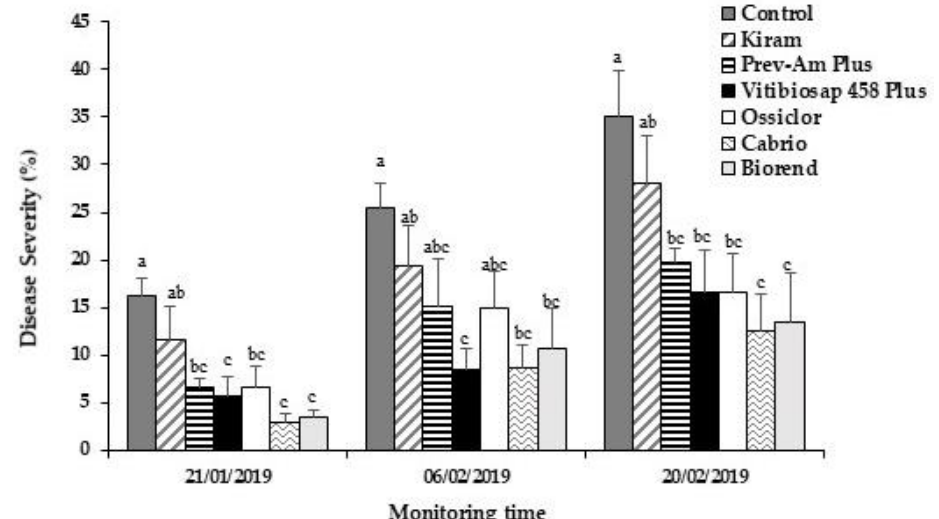
Figure 3. Time progression of disease severity on citrus fruit cv. “Tarocco Sciré” treat ed in the field with different alternative products, Ossiclor or Cabrio. Disease severity (DS%) was expressed as rating scale (see Section 4.5). Bars represent the standard error of the mean (SEM). Columns with different letters are statistically different according to Fisher’s least significance difference test (LSD) at p -value < 0.05.